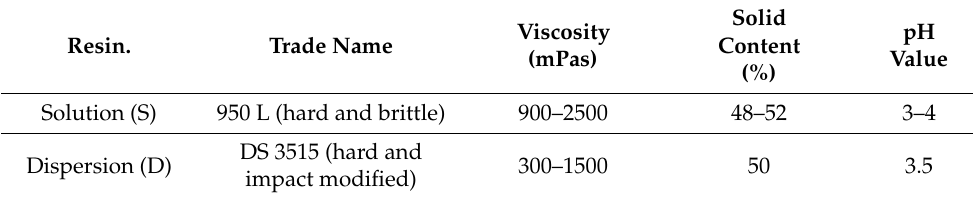
Table 1. Technical information about acrylic based polyester resins from manufacturer [33].